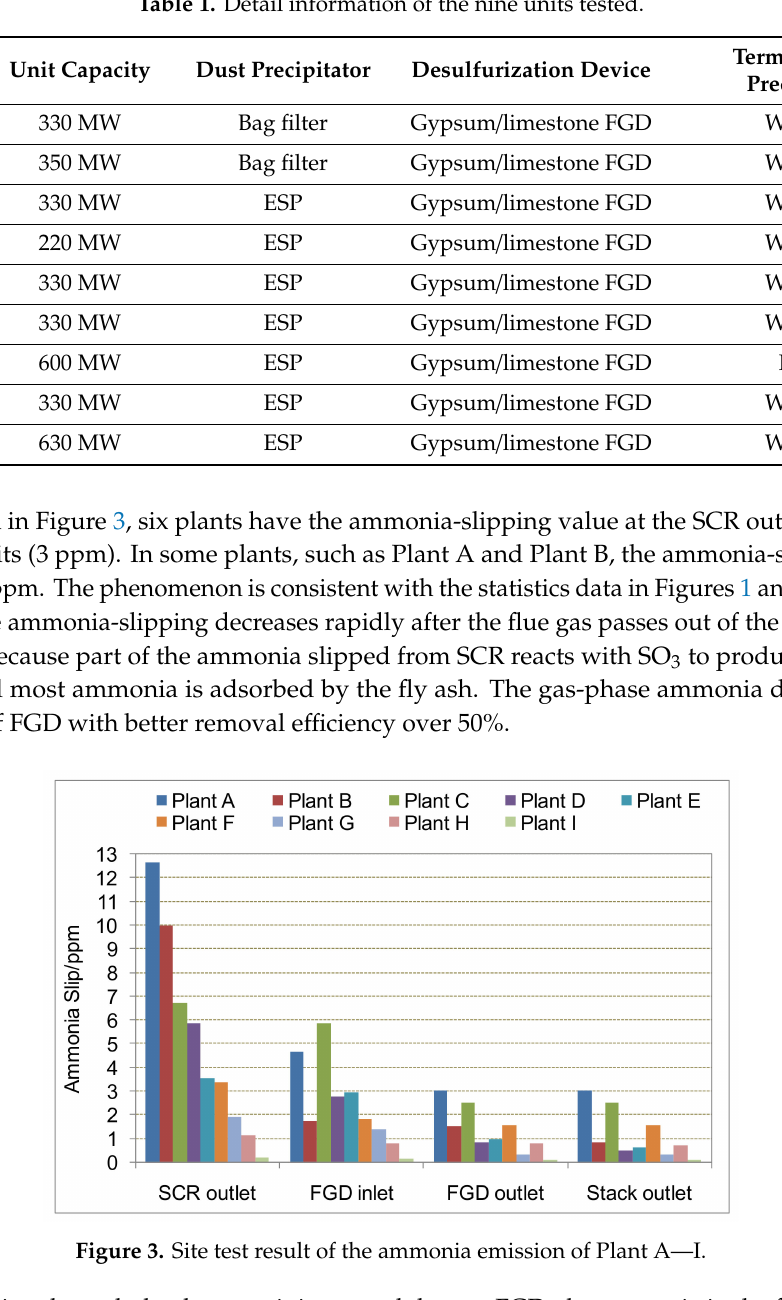
Table 1. Detail information of the nine units tested.